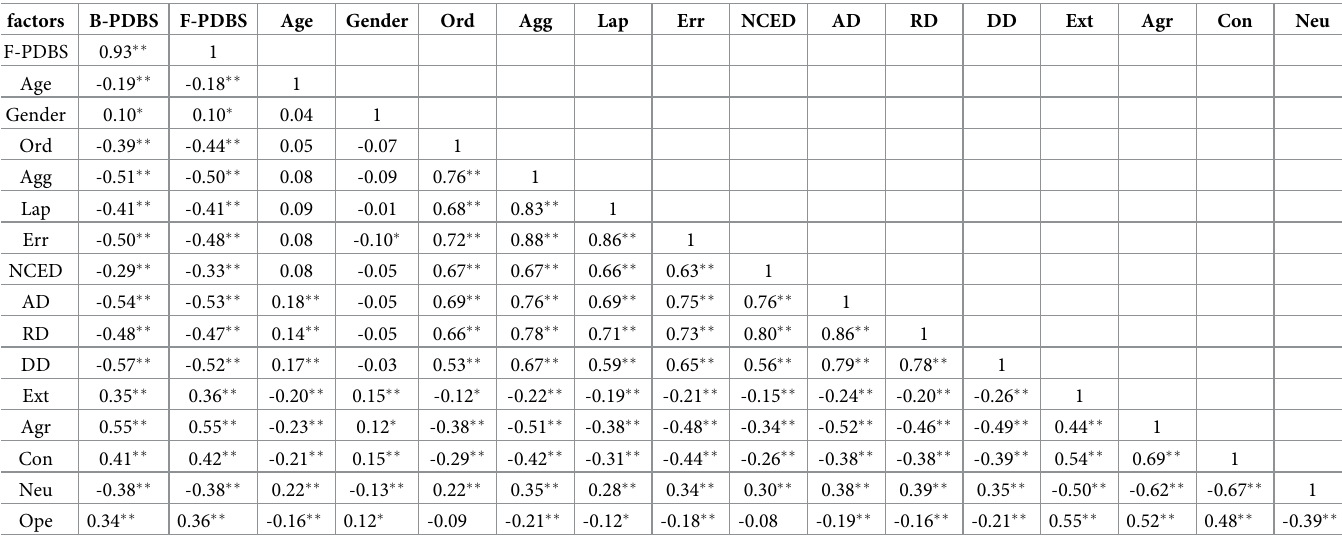
Table 3. Correlations among the PDBS, DBQ, DDDI and demographic